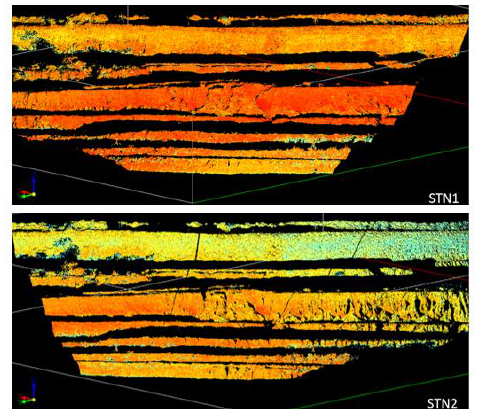
Figure 26. The difference scanner standpoint from two